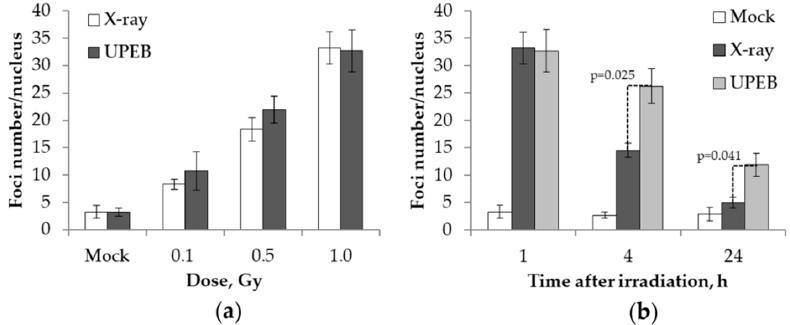
Figure 1. γ H2AX foci formation and elimination in the MRC5 cell line after UPEB and X-ray irradiation: ( a ) Dose-dependent (1 h after irradiation) increase in number of foci; ( b ) time-dependent (1 Gy irradiation dose) decrease in number of foci. Data represent the mean ± standard error of the results of three independent